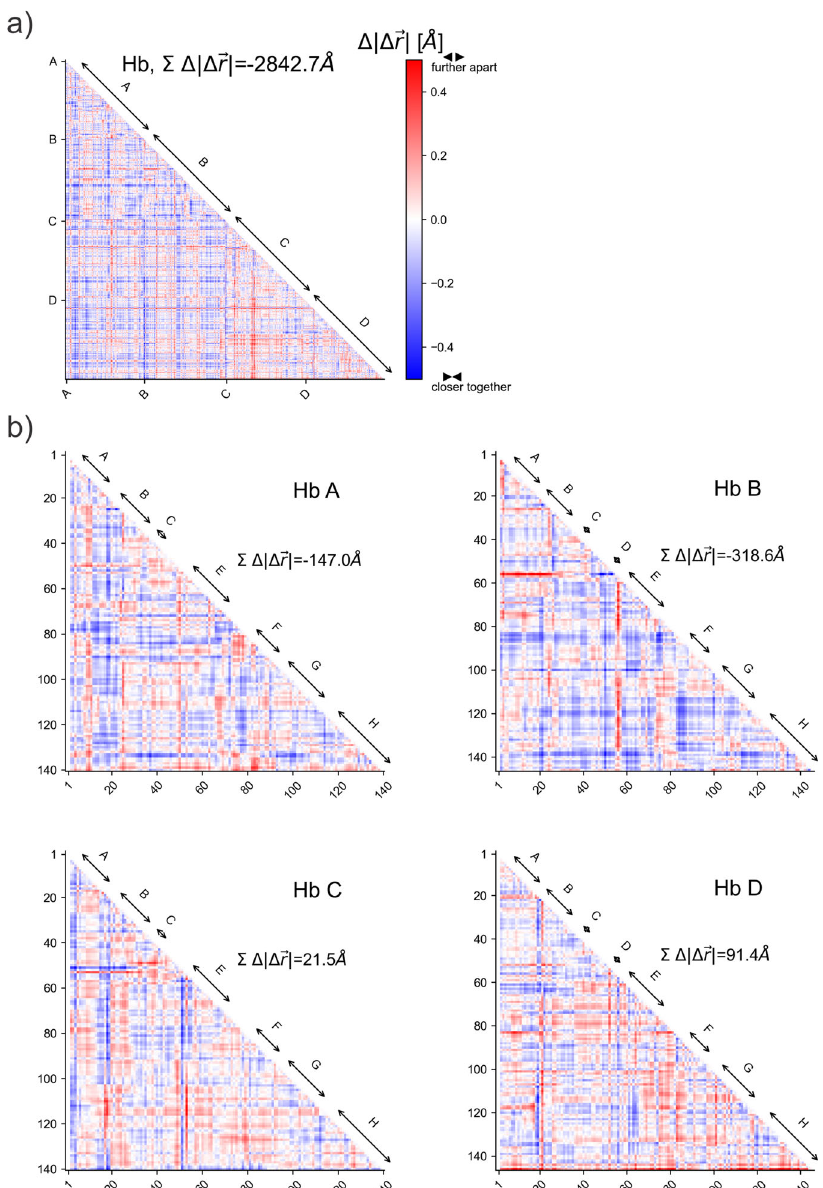
Fig. 5 Distance matrices showing the relative displacement of C α – C α pairs when comparing structures determined using the single-pulse data and the pump – probe data. Red indicates an increase of the distance, blue a decrease. The blue features dominate in the plot of the haemoglobin tetramer ( a ), as well as in the plots of the α 1 (HbA) and β 1 (HbB) subunits ( b ) indicating a clear compaction of the structure (see Supplementary Fig. 13). In contrast the α 2 (HbC) and β 2 (HbD) subunits slightly expand ( b ). Compaction and expansion are also clearly apparent from the sum of the relative changes. Correlated movements of secondary structure elements can be observed in the plots as extended streaks of blue or red colour (e.g., parts of the α 1-A helix move closer to the core of the α 1 subunit, similarly part of the β 1 EF loop and the F helix move closer to the β 1core,